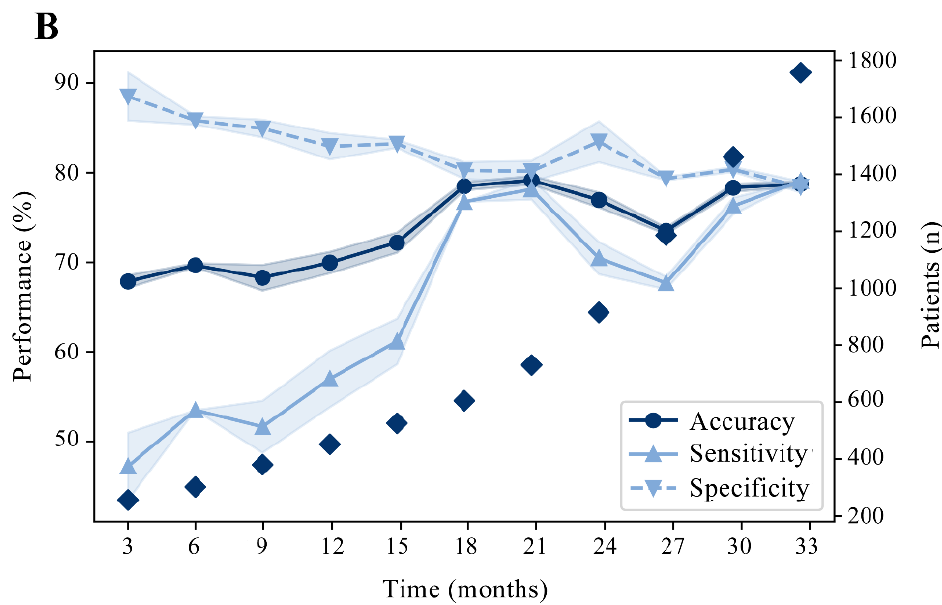
Figure 4. Continual Learning of RAIN-ML prediction model. Graphs showing diagnostic performance (left y-axes) with a continual learning strategy in the discovery cohort (n = 2393). Squares indicates the number of patients (right y-axes) over the enrolment time (x-axes). ( A ) Learning simulation for RAIN-ML prediction model at the increase in the enrollment time; 70% of the discovery cohort is used for training (patients enrolled first), 30% for validation (last enrolled patients). Mean and standard deviation are shown after 10 repetitions of the analysis. Accuracy at training: from 86.1% to 79.9%. Accuracy at validation: from 67.9% to 78.7%. ( B ) Accuracy, sensitivity, and specificity at validation.